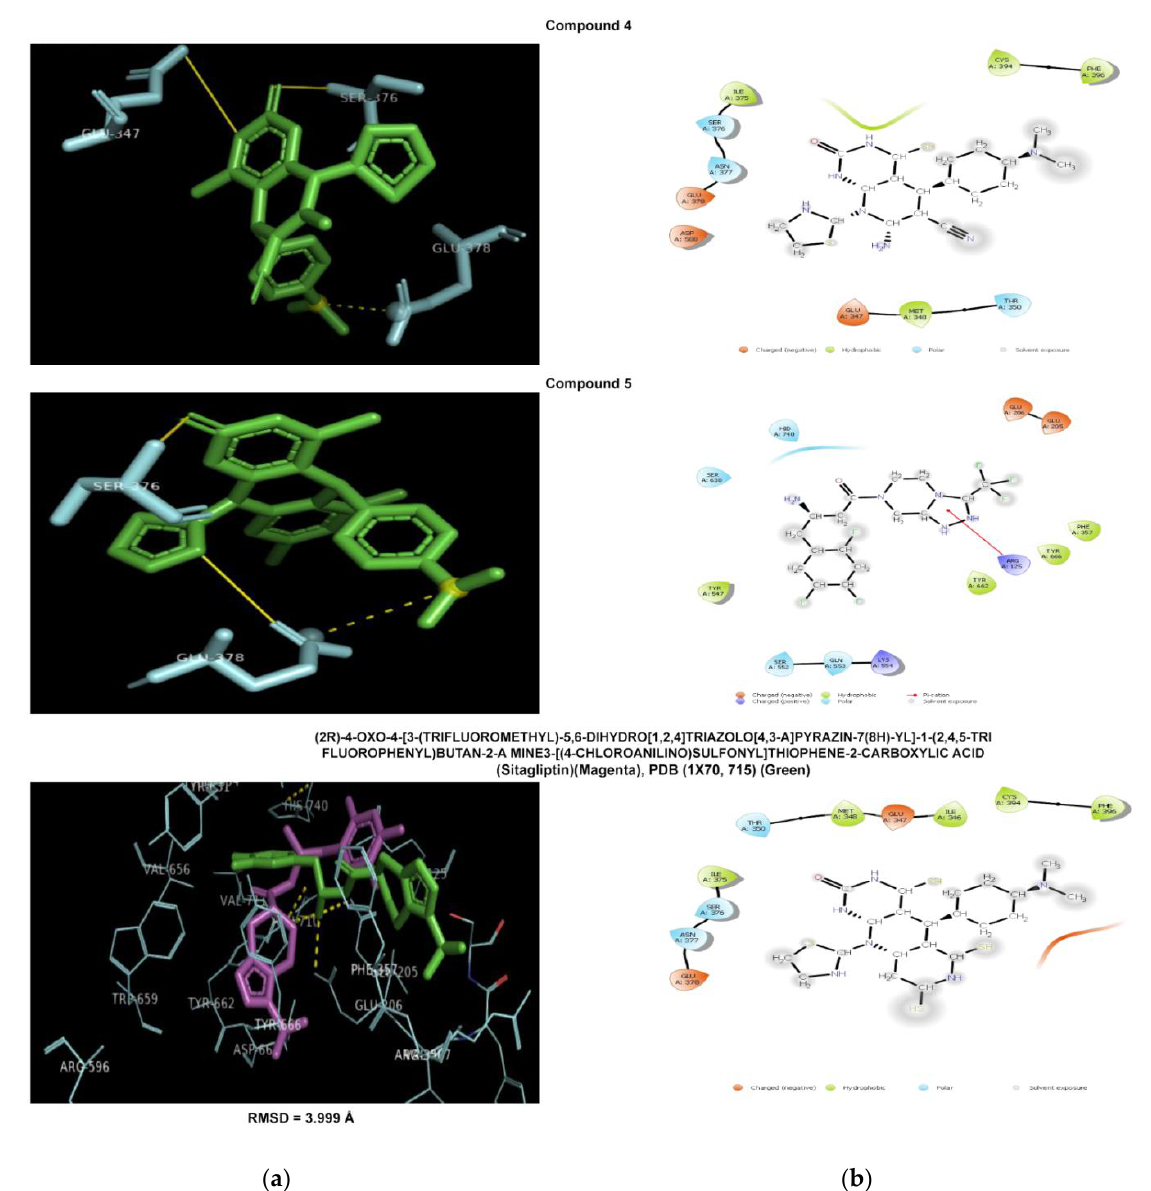
Figure 8. The binding states ( A ) shows hydrogen bonds residues coloredin cyan and 2D interaction diagrams ( B ) for the compounds 4 and 5 and sitagliptin in co-crystallized stateligand (green) and docked state (magenta) against human dipeptidyl peptidase IV obtained from the PDB structure (1 × 70).